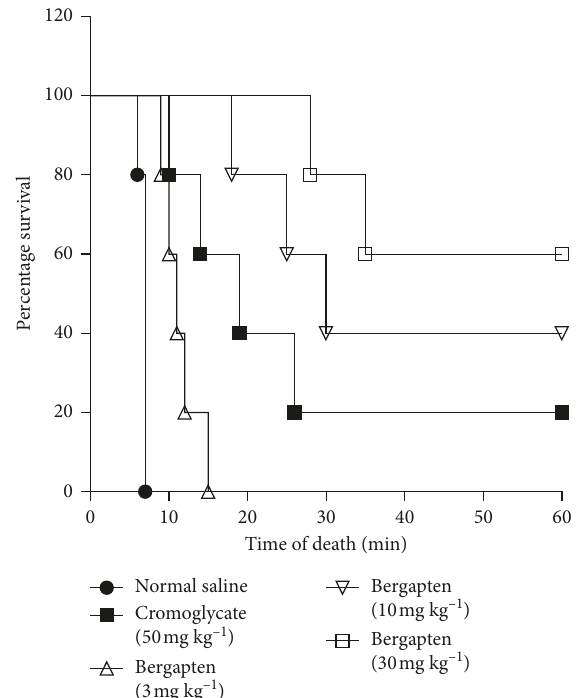
Figure 2: Effect of bergapten on C48/80-induced systemic ana- phylaxis. C57BL/6 mice received either saline 10ml kg − 1 , disodium cromoglycate 50 mgkg − 1 , or bergapten 3–30 mgkg − 1 , p.o ., and challenged with C48/80 (8mg kg − 1 , i.p .) 1 h later. Mortality was monitored for 1 h. Data were analyzed using the log-rank (Mantel–Cox) test. Survival curves were significant p < 0 .